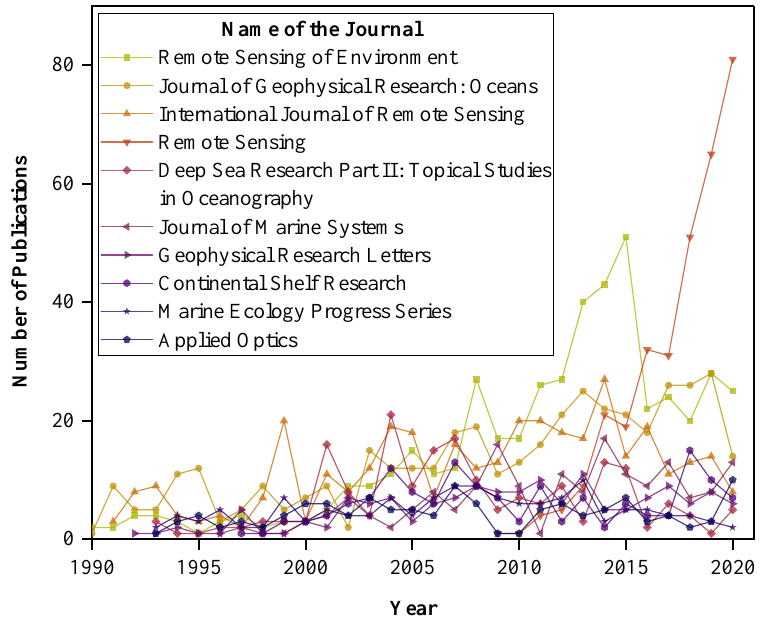
Figure 2. Trends in the number of papers published in major journals.